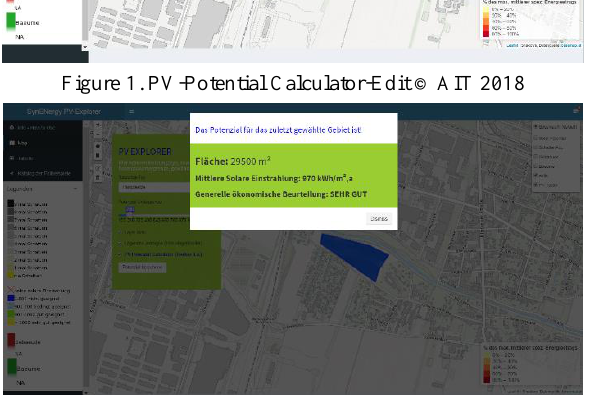
Figure 2. PV-Potential Calculator-Results © AIT